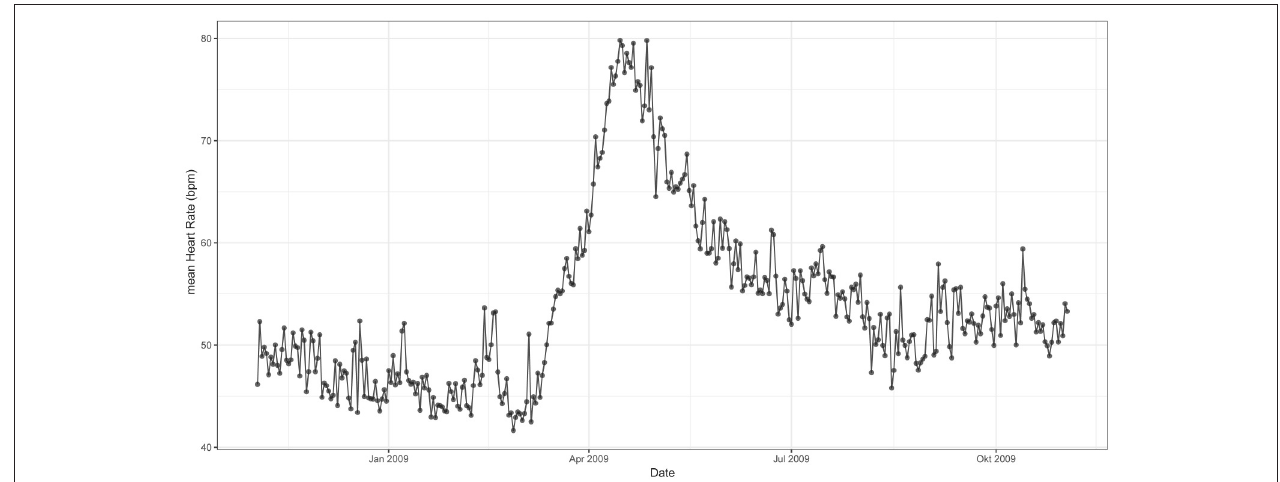
FIGURE 4 | Mean HR from 12 p.m. to 6 p.m. throughout the 12 months study period [x-axis date (month), y-axis HR (bpm)]. HR is lower during the winter than during the summer—it experiences a peak in